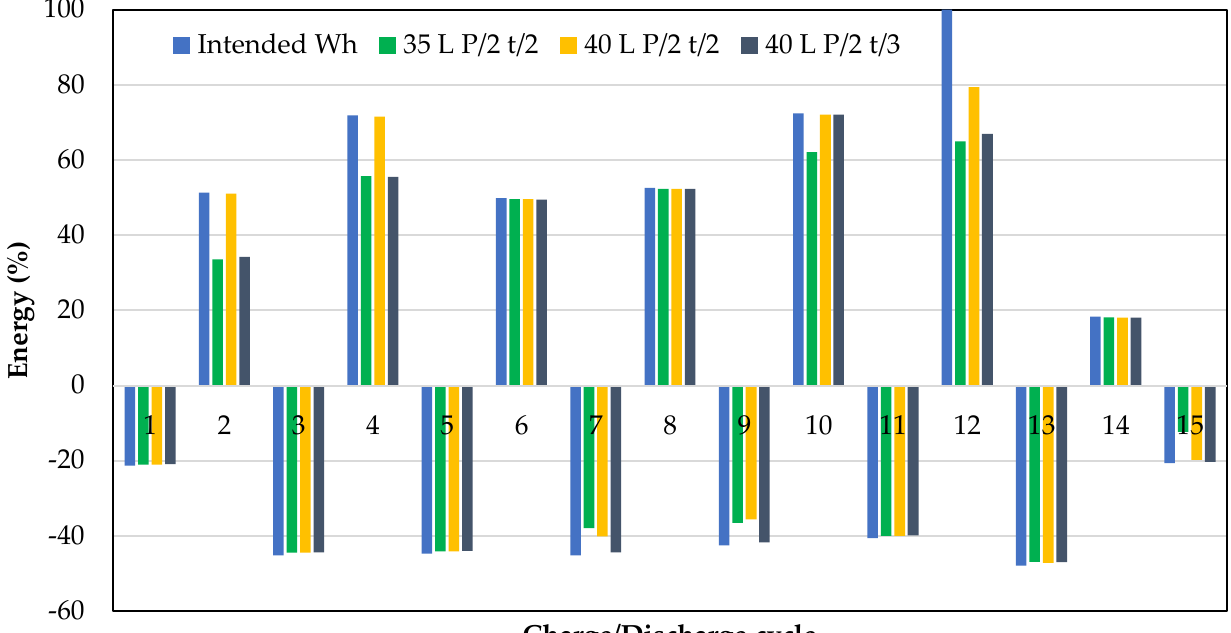
Figure 5. Comparative plot showing traded energy (%) in each charge/discharge cycle over a seven-day period for a VRFB with (electrolyte volume, S P and S T ) combinations of (35 L, ½ , ½ ), (40 L, ½ , ½ ) and (40 L, ½ , 1 / 3 ).